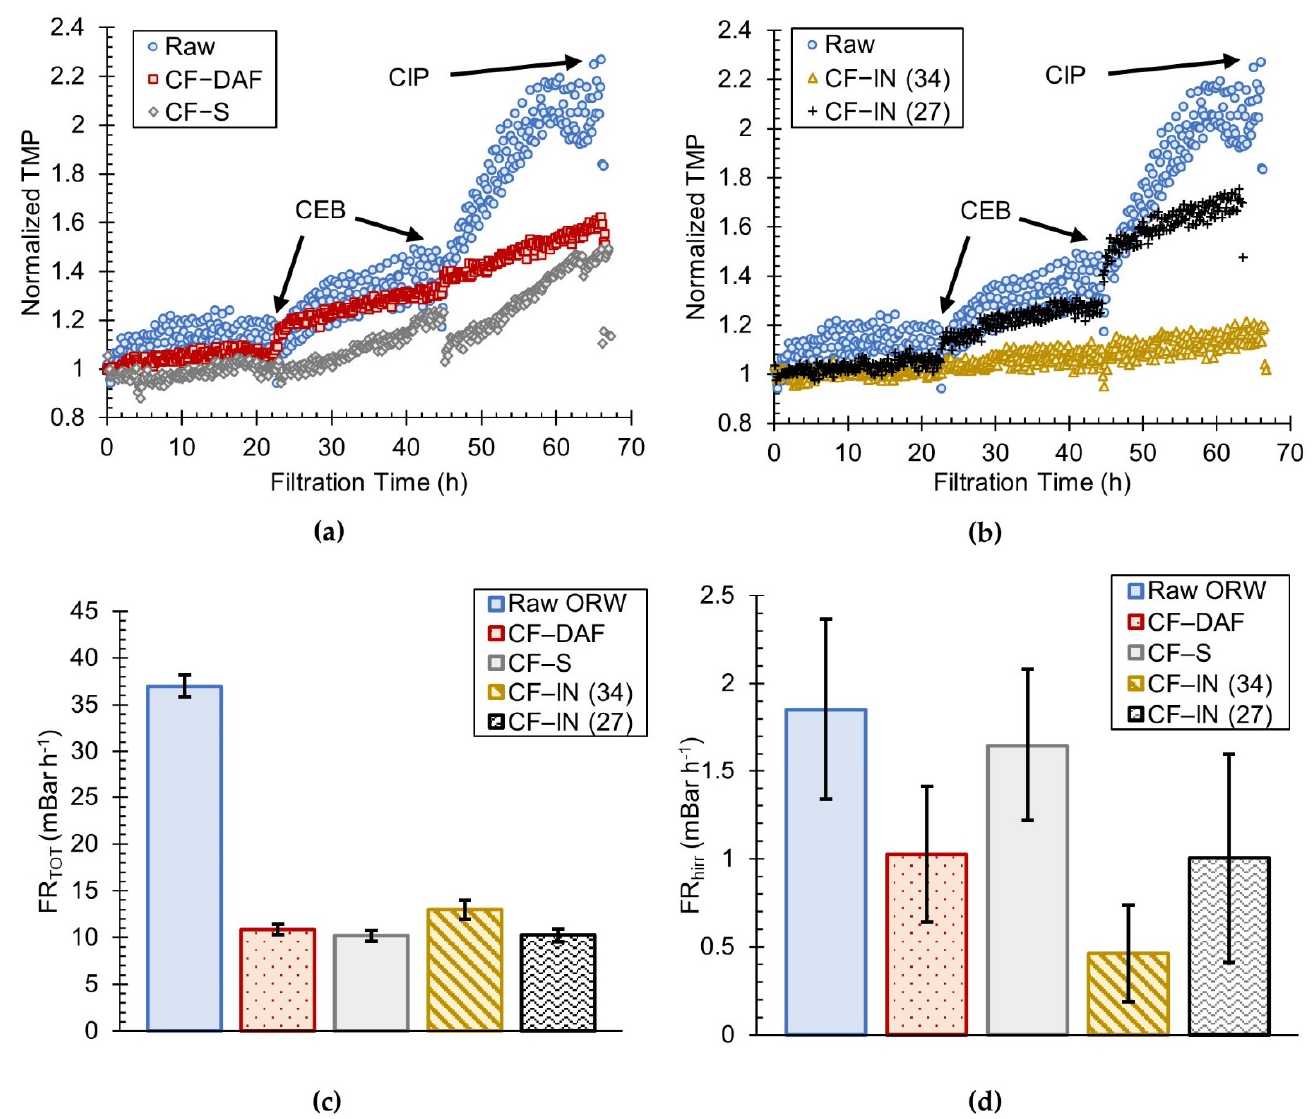
Figure 3. Comparison of ORW w filtration tests: ( a ) raw ORW, CF–S, CF–DAF nTMP profile; ( b ) raw ORW and CF–IN nTMP profile; ( c ) three–day average total FR; ( d ) three–day average hydraulically irreversible FR.